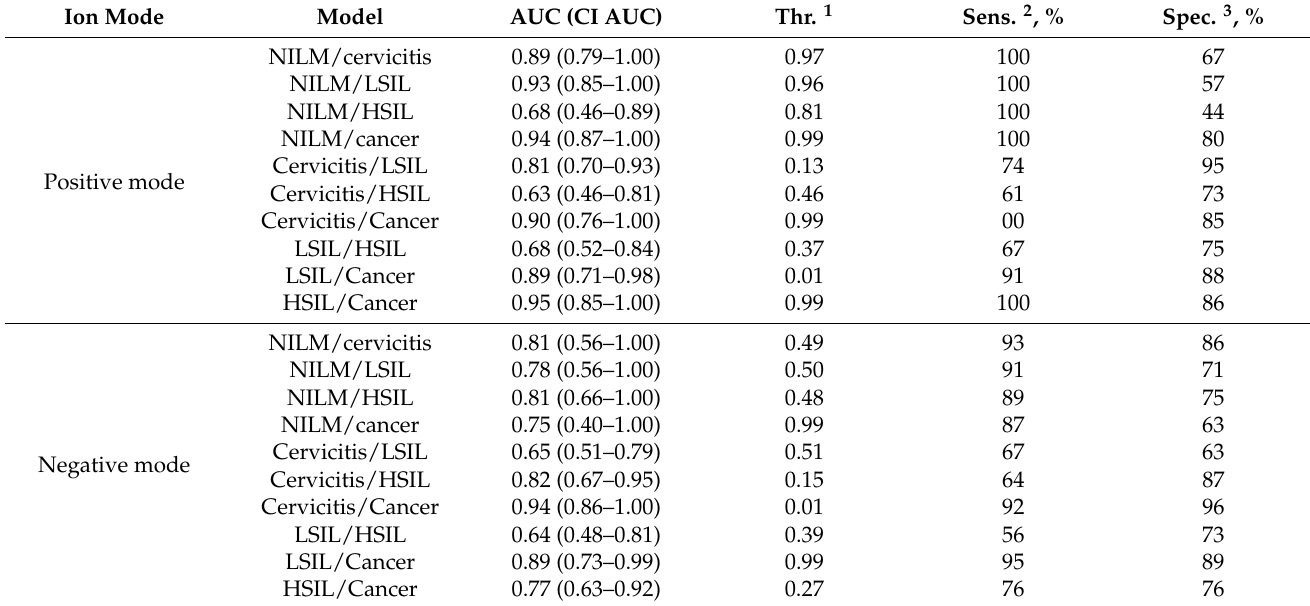
Table 2. Parameters of discriminative models based on logistic regression obtained during cross-validation.